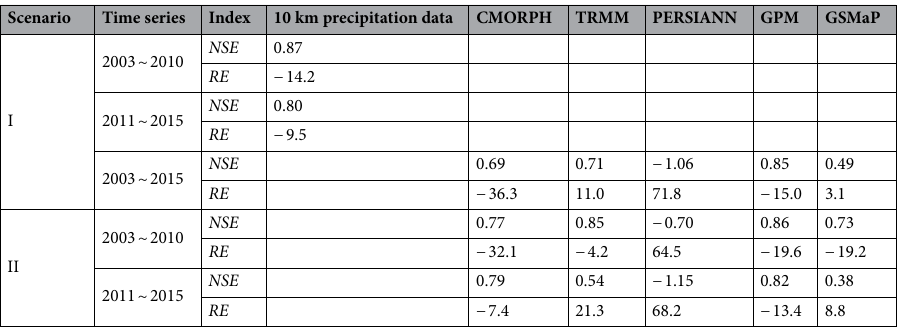
Table 3. The VIC model accuracy in streamflow simulation driven by various precipitation data under two scenarios. NSE indicates Nash–Sutcliffe efficiency, and RE is relative Error (%).